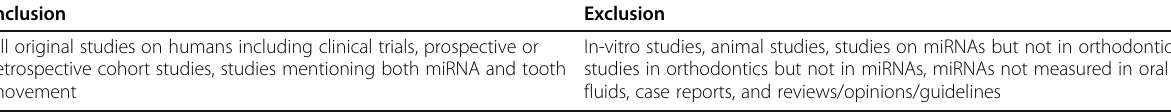
Table 1 Inclusion and Exclusion criteria for